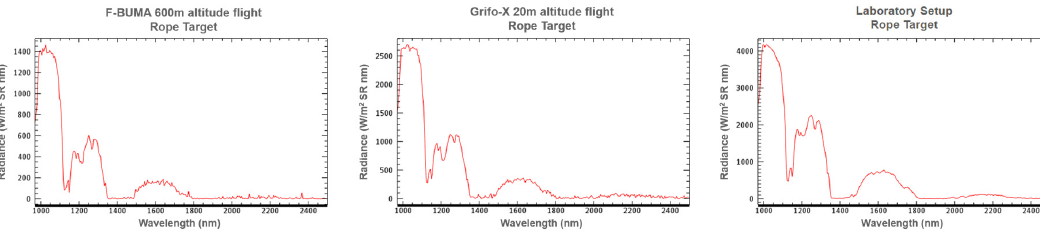
Figure A5. Comparison between the bright pixels for the 25/09 flight 1 with Grifo-X, 20/09 F-BUMA flight and the laboratory morning results for all the target materials. Figure A6 shows a comparison between the data from the same target (rope) at three different situations: F-BUMA flight at 600 m altitude, Grifo-X flight at 20 m altitude and using the laboratory setup.